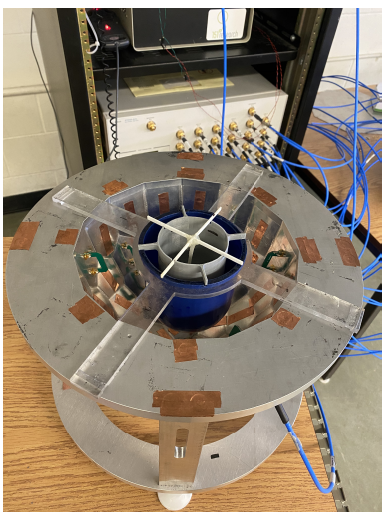
Figure 1. Photograph of the experimental setup with breast